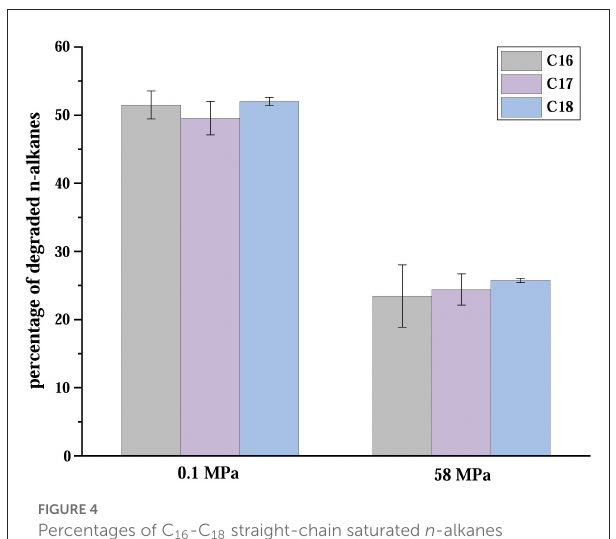
FIGURE4 Percentages of C 16 -C 18 straight-chain saturated n- alkanes degraded in 10 days in atmospheric and in situ conditions. The error bars are based on triplicate